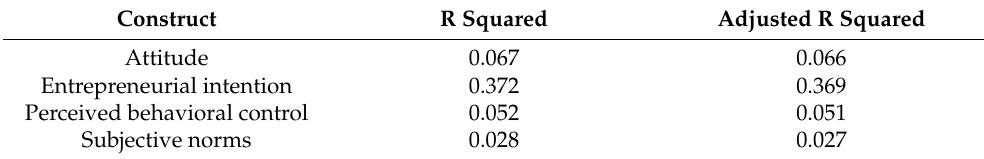
Table 4. R-squares.